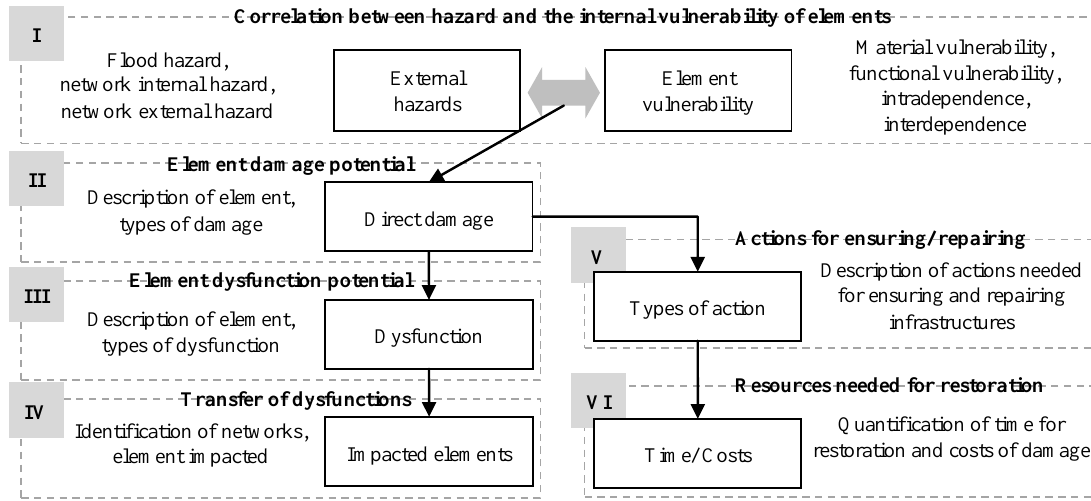
Figure 2. Structure of damage-dysfunction matrices. 2 Fig. 2. Structure of damage-dysfunction